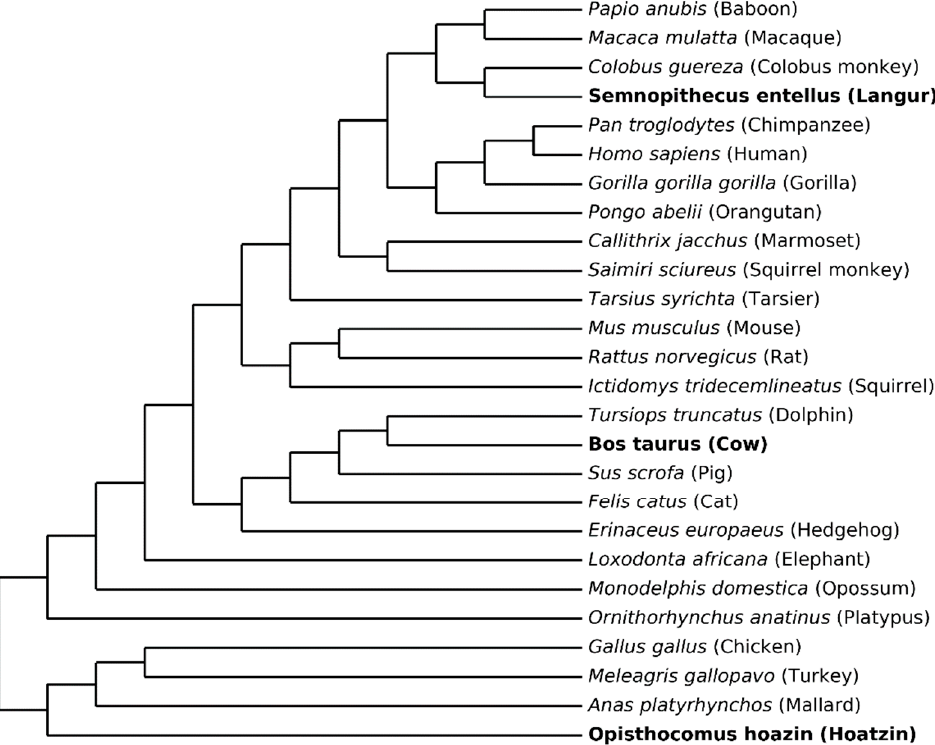
Figure 3. An unscaled tree representing the phylogenetic relationships among 26 mammalian and avian species used in this study. The phylogenetic tree represents a strict consensus tree derived from [22–25]. Three foregut fermenters are shown in bold.